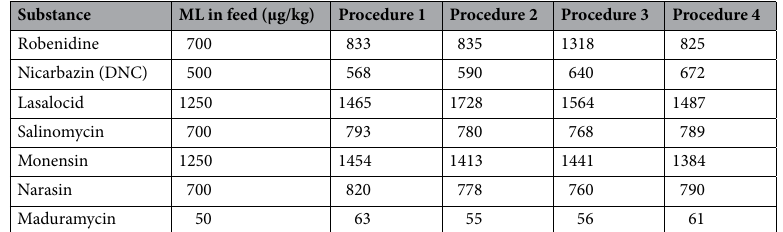
Table 5. Within-laboratory repeatability and reproducibility of determination of coccidiostats for each procedure.